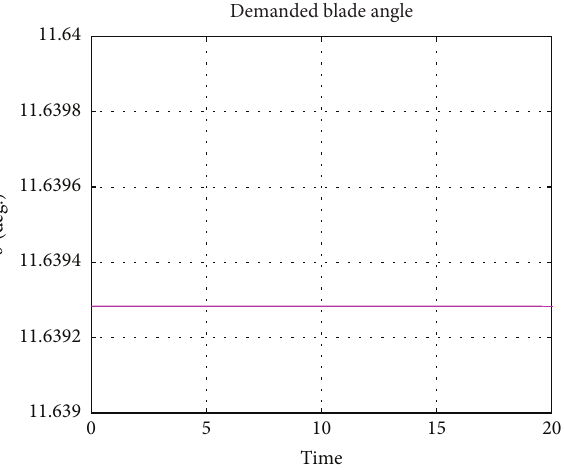
Figure 10: Demanded blade angle in degrees corresponding to Figure 9. local blade chord and the blade twist or the aerofoil inlet angle along the blade length.) Hence our optimum demanded blade angle based controller, obtained by minimizing the mean square error between the actual power output and desired power output, resembles an active stall flow controller. The MPC law, used as part of the controller, has the structure of a full state feedback controller except that the feedbacks involving the blade angle and blade angle rate are interpreted as the feedbacks involving 𝑒 = 𝜃 − 𝜃 𝑑 and ̇𝑒 . Thus we have provided a new and practical method of synthesizing an active stall flow controller, where the feedback control law is derived by applying the concept of